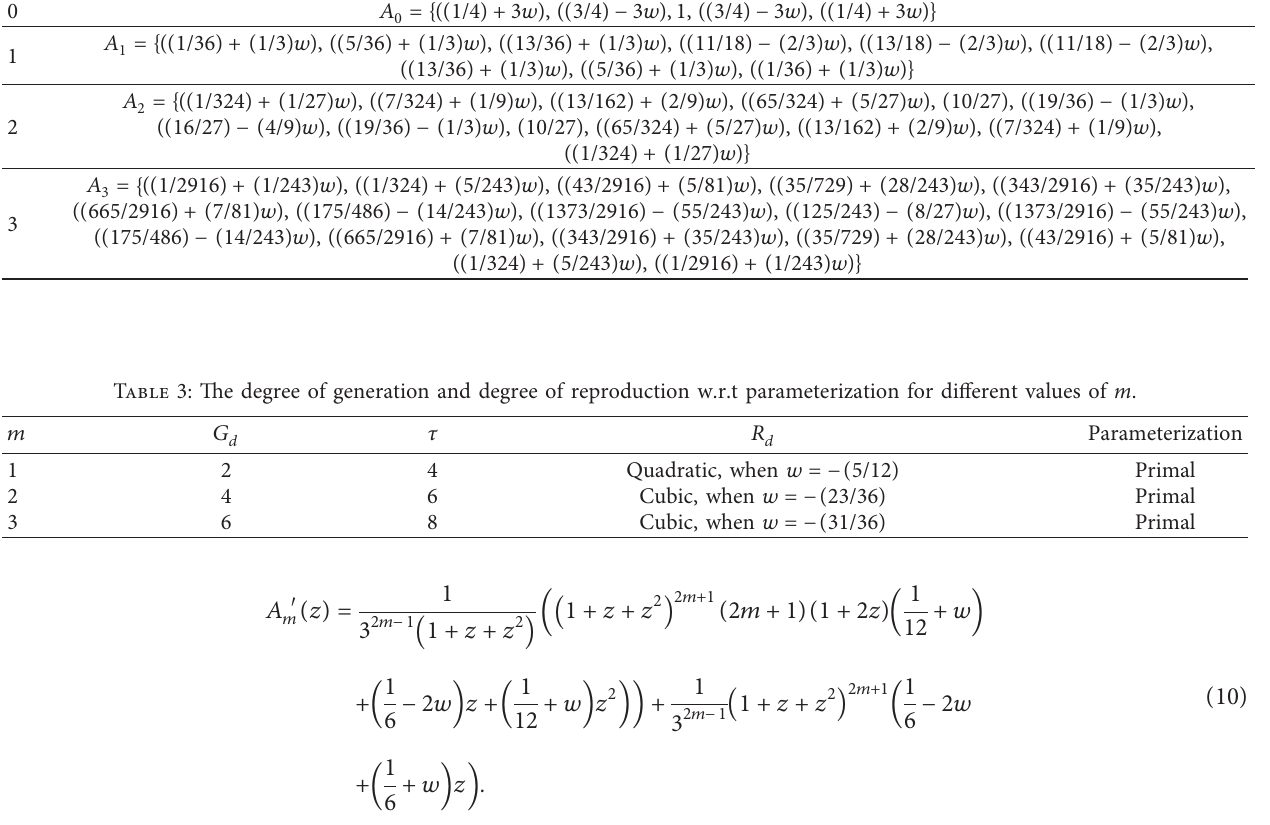
Table 2: The mask of integer-point ternary subdivision schemes A m Mask